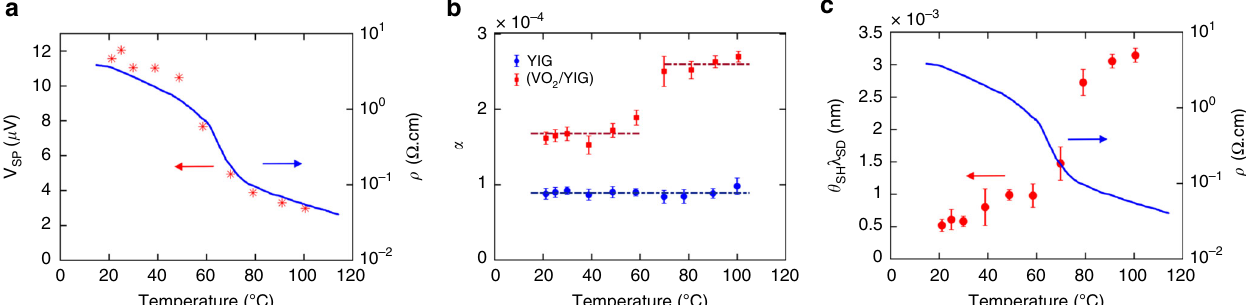
Fig. 3 Variation of V SP and charge-spin conversion across transition. Temperature dependence of a spin pumping voltage and resistivity of a VO 2 (68 nm)/YIG (100 nm) sample, b Gilbert damping coef fi cient of bare YIG (blue) and VO 2 (68nm)/YIG (100 nm) (red) (the dash-dotted lines are drawn to guide the eye), and c variation of θ SH λ SD of VO 2 (68nm)/YIG (100 nm) sample across the metal-insulator transition. Error bars in this fi gure re fl ect uncertainties (standard error) in linear fi tting of the damping coef fi